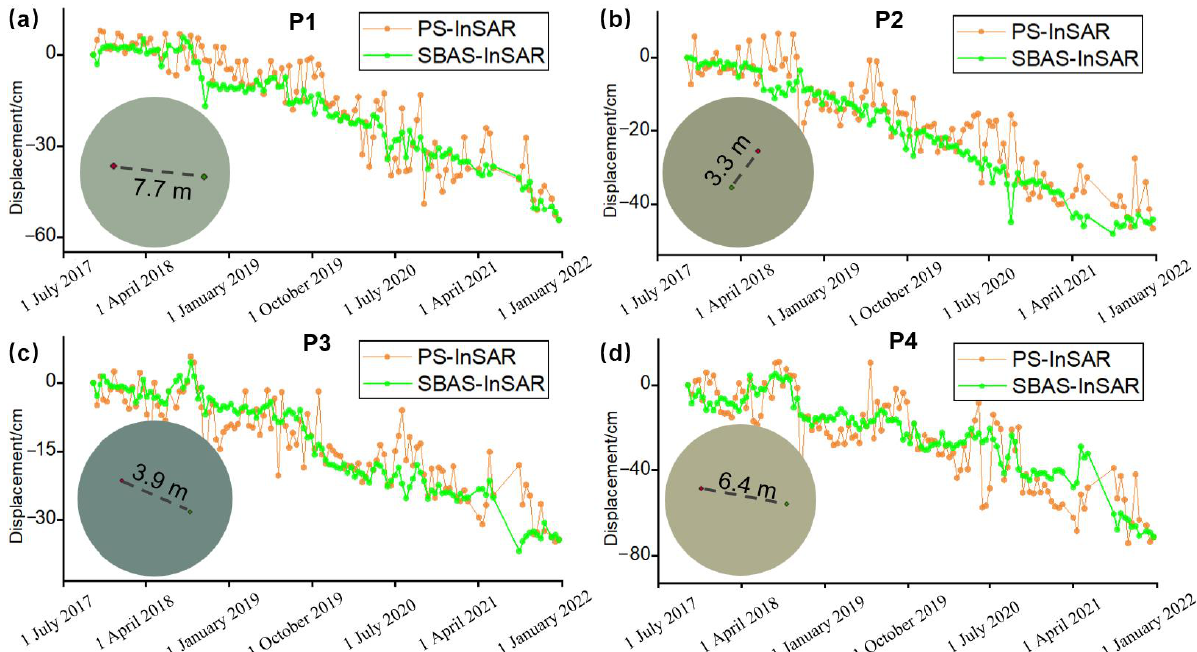
Figure 14. Comparison between SBAS and PS-InSAR deformation in the LOS direction at four larger deformation points. ( a – d ) show the displacement data of four points marked in Figure 13a. Red and green lines indicate the PS-InSAR and SBAS deformation time-series, respectively. The relative spatial positions of PS and SBAS points are shown in the circle diagram.